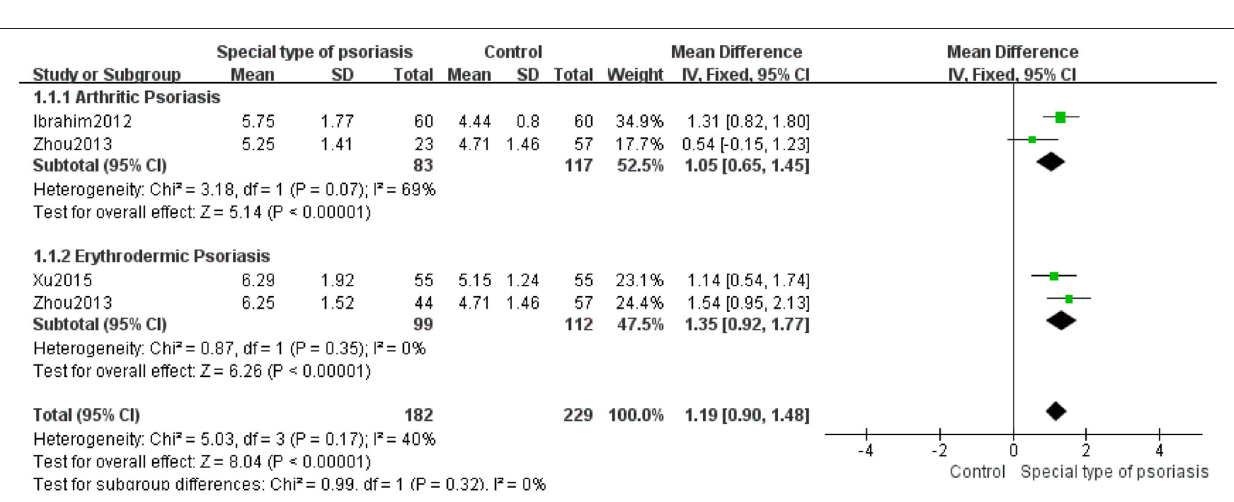
FIGURE 8 | Meta-analysis of the SUA levels of patients with a special type of psoriasis vs. controls. The MD in SUA levels of patients with a special type of psoriasis compared to controls. The point estimate (center of each green square) and statistical size (proportional area of the square) are represented. The horizontal lines indicate the 95% confidence intervals. The subtotal and total MD (diamond) were calculated using a fixed-effects model. MD, mean difference; SUA, serum uric